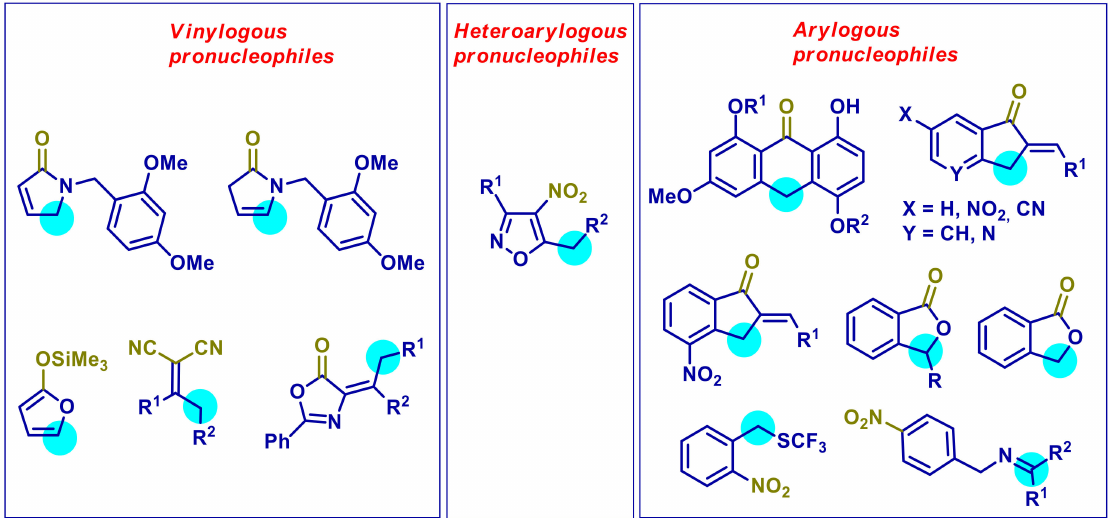
Figure 1. Vinylogous and (hetero)arylogous pronucleophiles employed in PTC processes. Blue halos indicate the preferential nucleophilic site. The leading electron-withdrawing group is marked in